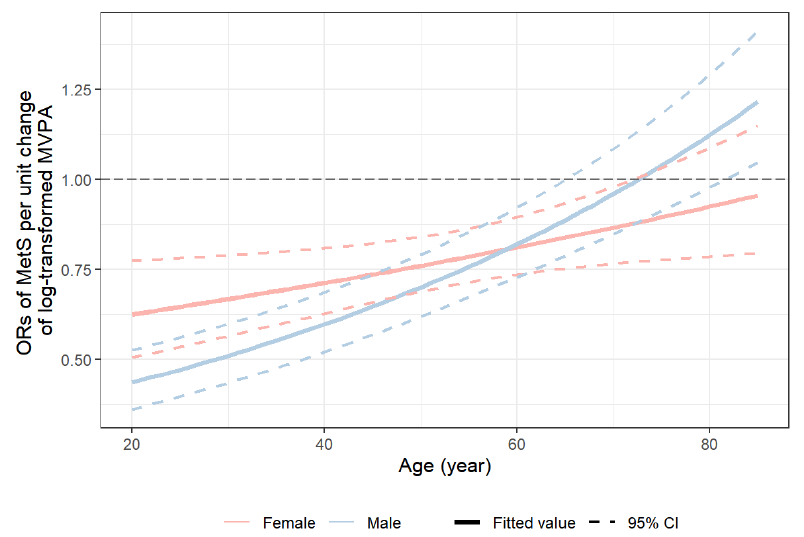
Figure 3. Adjusted association between MVPA time and MetS according to age. Y axis is the predicted odds ratio of MetS per unit change in log e (MVPA + 1) time in a logistic regression model with sex, age, log e (MVPA + 1), and their two-way and three-way interactions and adjusted for race/ethnicity (White, Mexican American, Other Hispanic, Black, and others), BMI, smoking status (never, former, and current), drinking status (non-drinker, moderate drinker, and heavy drinker), and total daily energy intake.